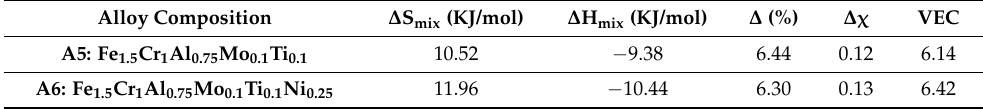
Table 1. Physicochemical properties of the designed HEA compositions. Alloy